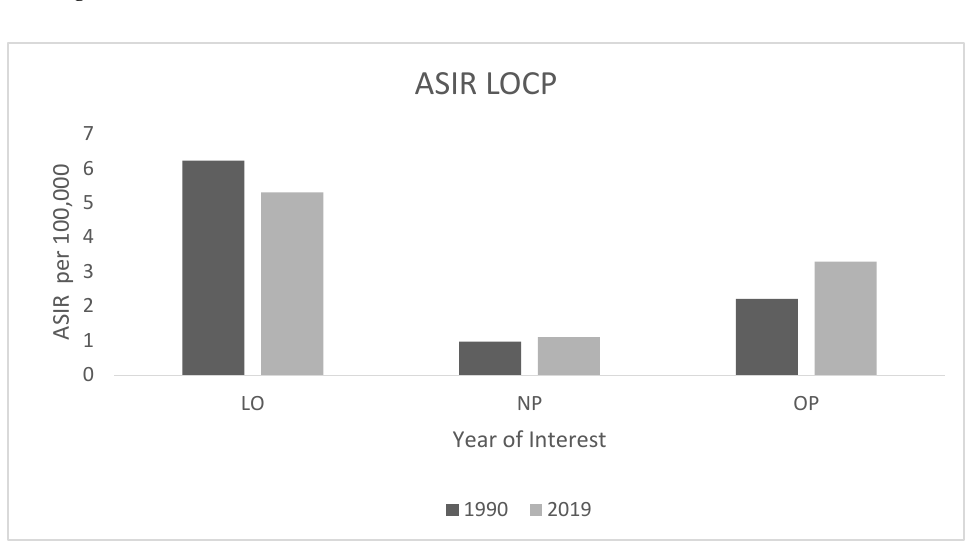
Figure 2: ASIR of LOCP between 1990 and 2019.